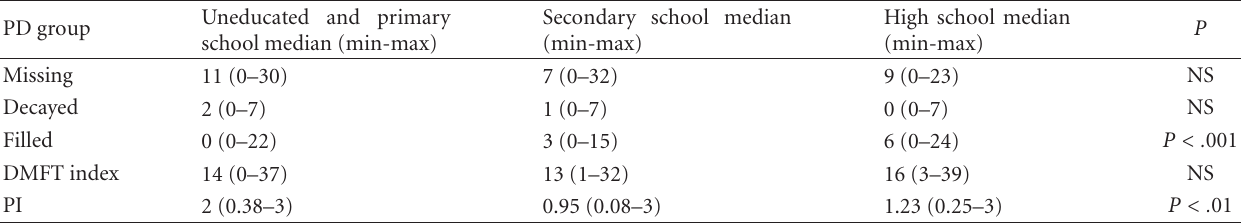
Table 3: Median (min-max) values and statistical comparisons for decayed, missing, and filled teeth, DMFT index, and PI values in the PD group.